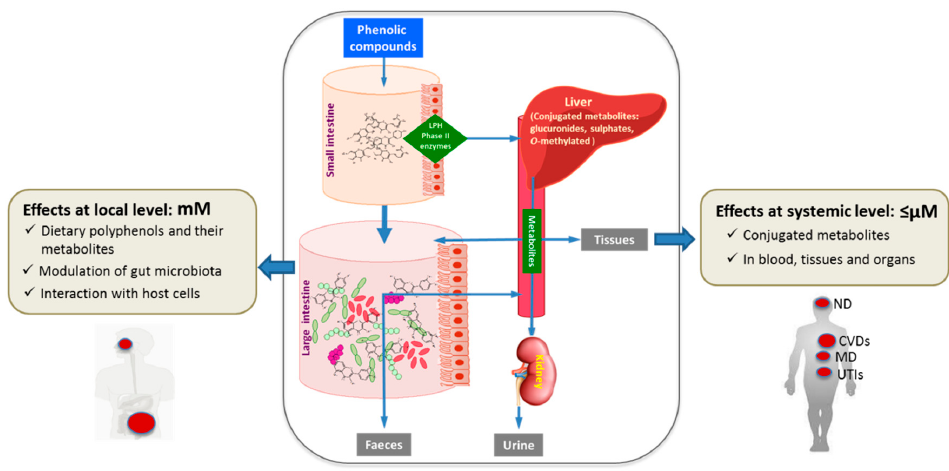
Figure 1. Integrated overview of the metabolism and health effects of dietary polyphenols. Abbreviations. ND: neurological disease; CVDs: cardiovascular diseases; MD: metabolic disorders; UTIs: urinary tract infections.